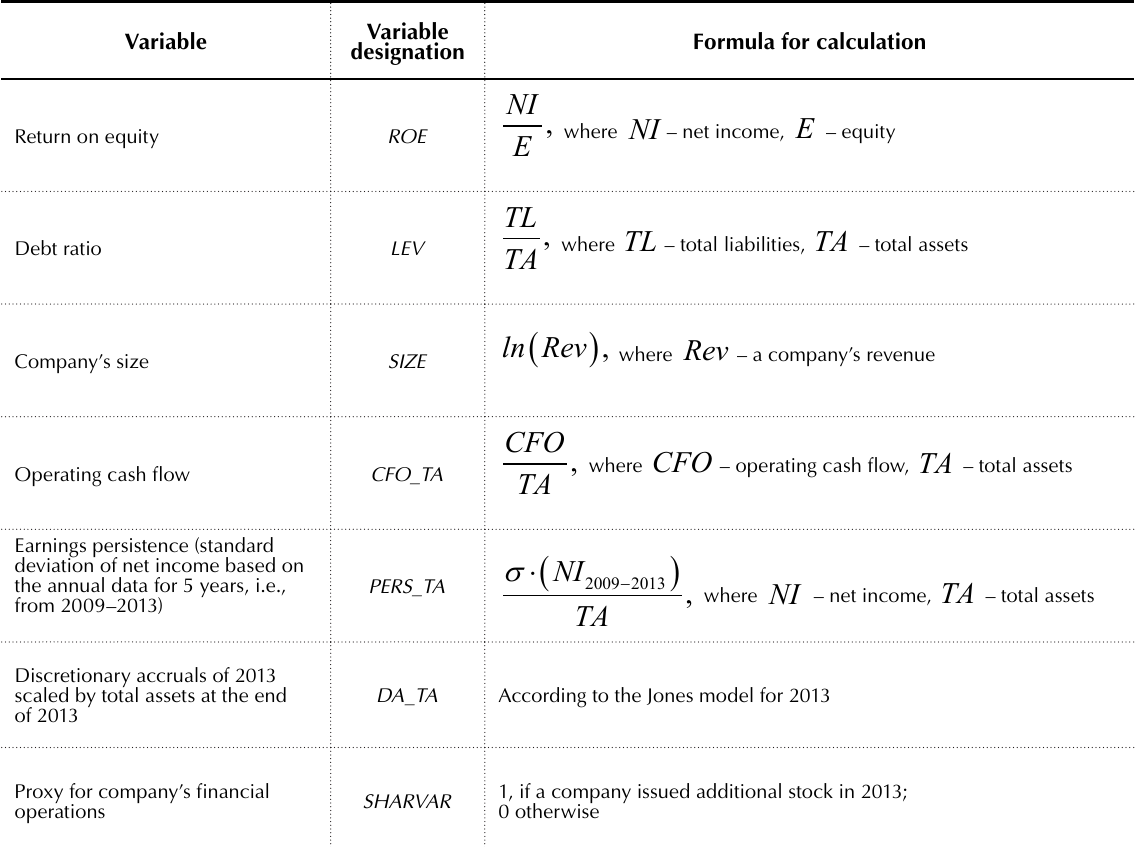
Table 1. Variables used to forecast companies’ level of earnings